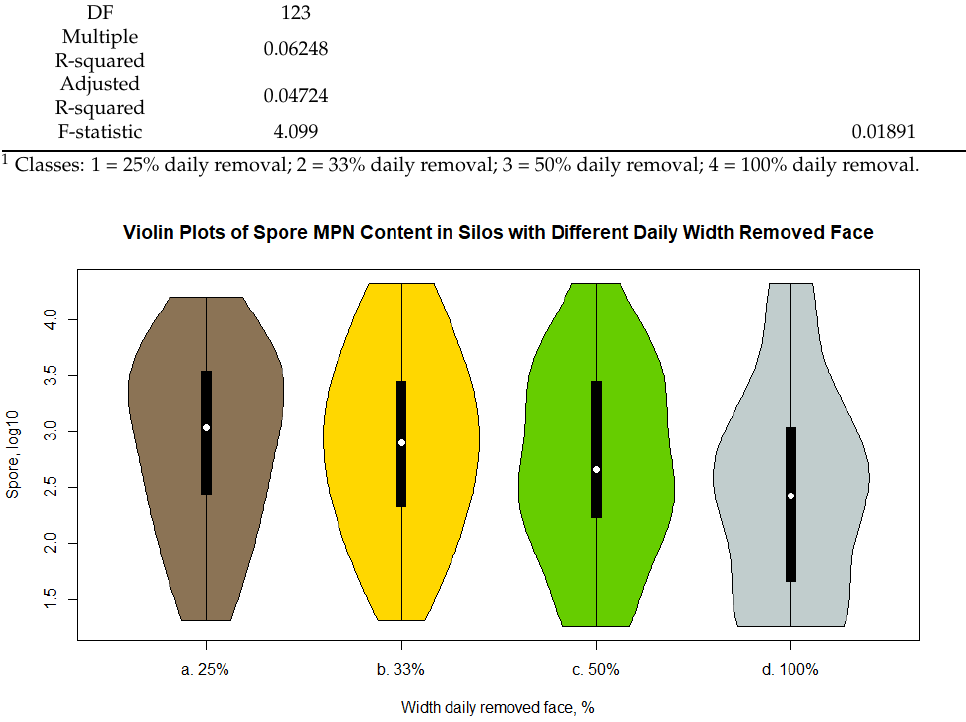
Figure 4. Distribution of anaerobic spore-forming bacteria spores (MPN, log 10 n /g) for the four classes of daily removal width of exposed silage surface (percentage) for the silos sampled within the study.